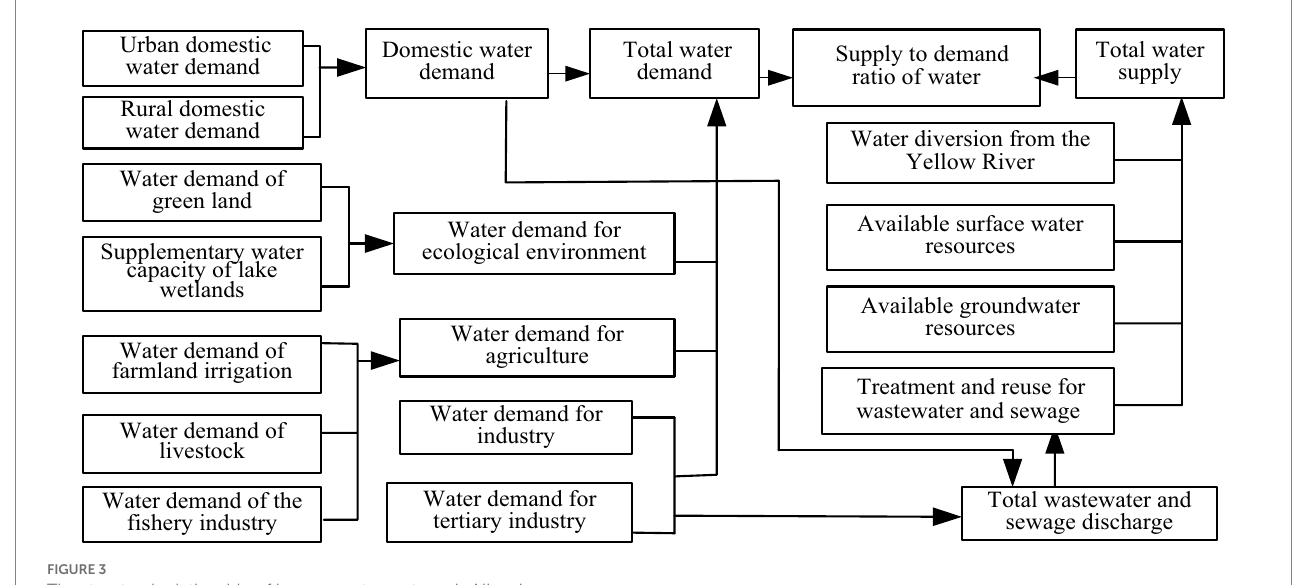
FIGURE 3 The structural relationship of human-water systems in